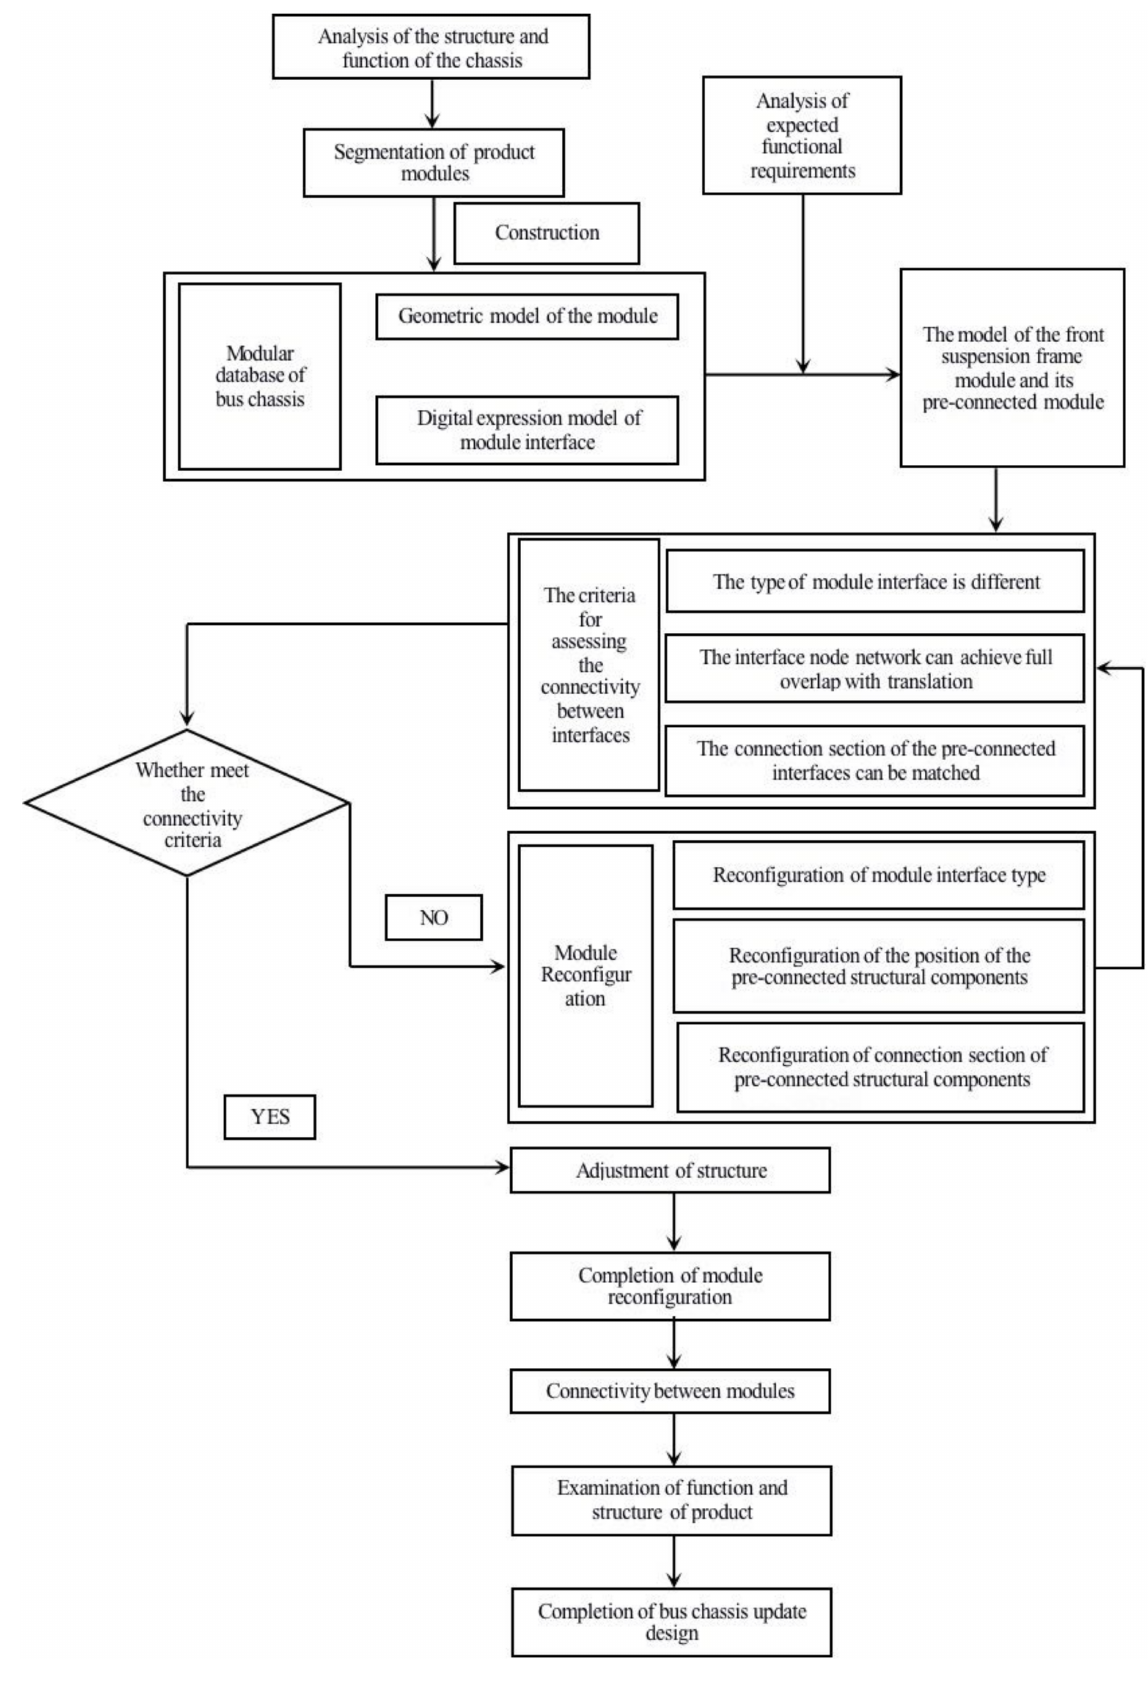
Figure 8. The updated design process for the bus